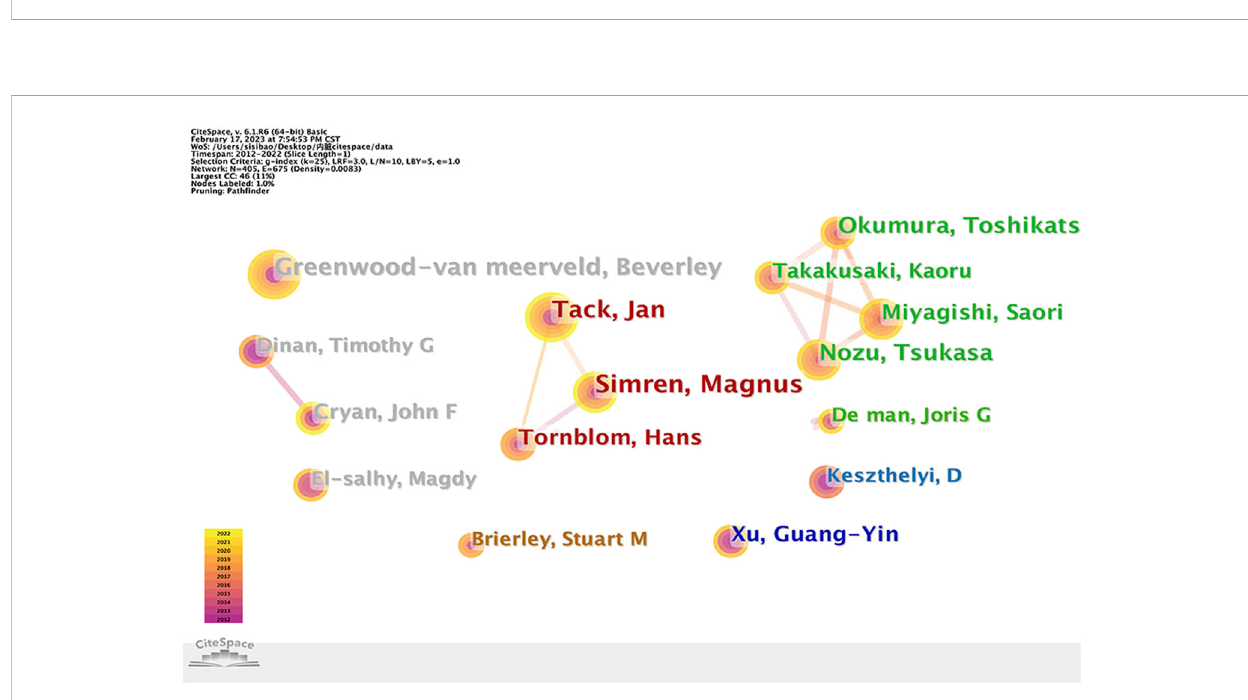
FIGURE 5 Authors ’ collaboration network of research on IBS and the visceral